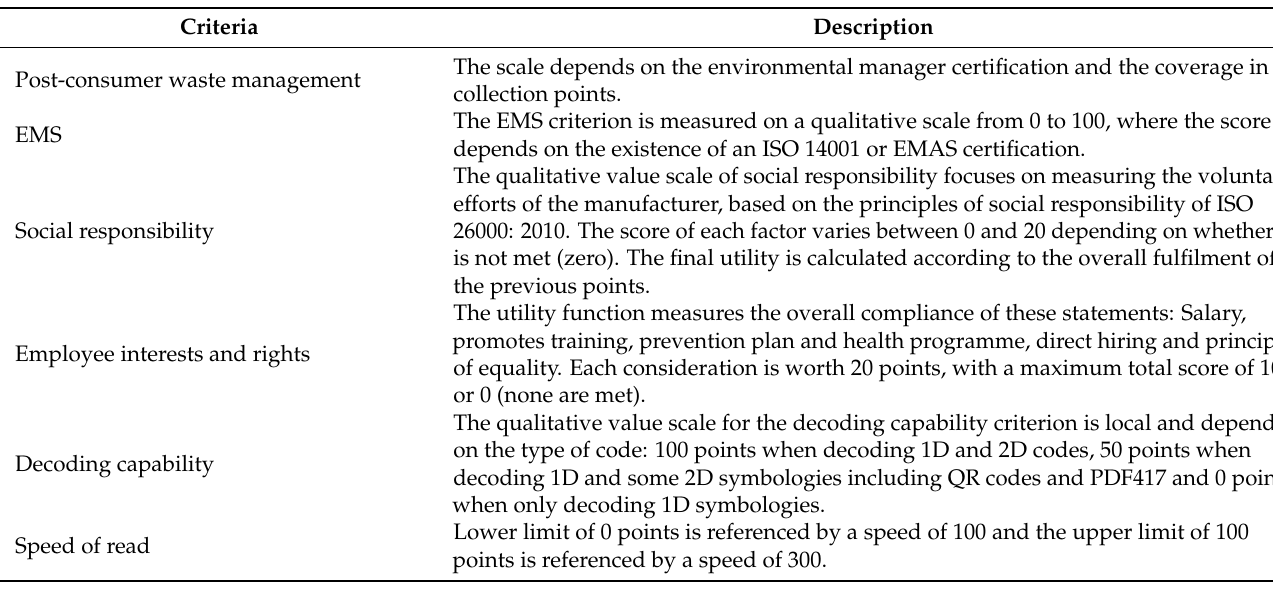
Table A2. MAUT: utility functions.